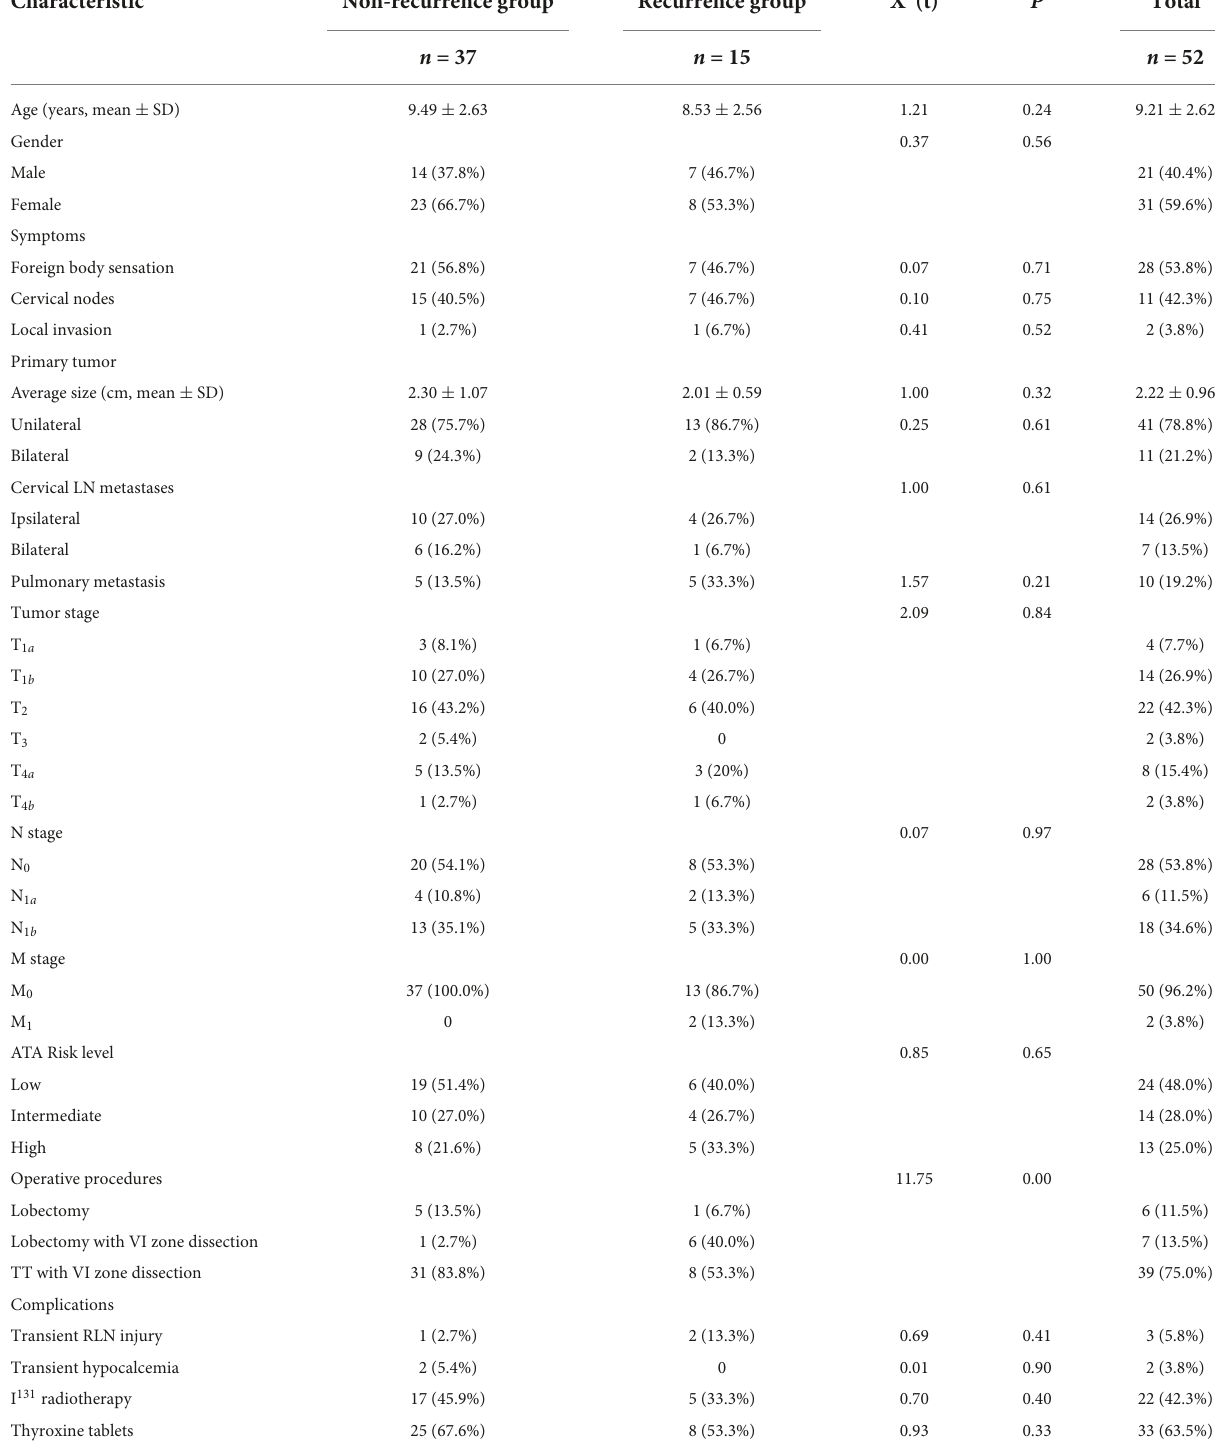
TABLE 3 Clinical analysis of the recurrent group and non-recurrent group of DTC in children.